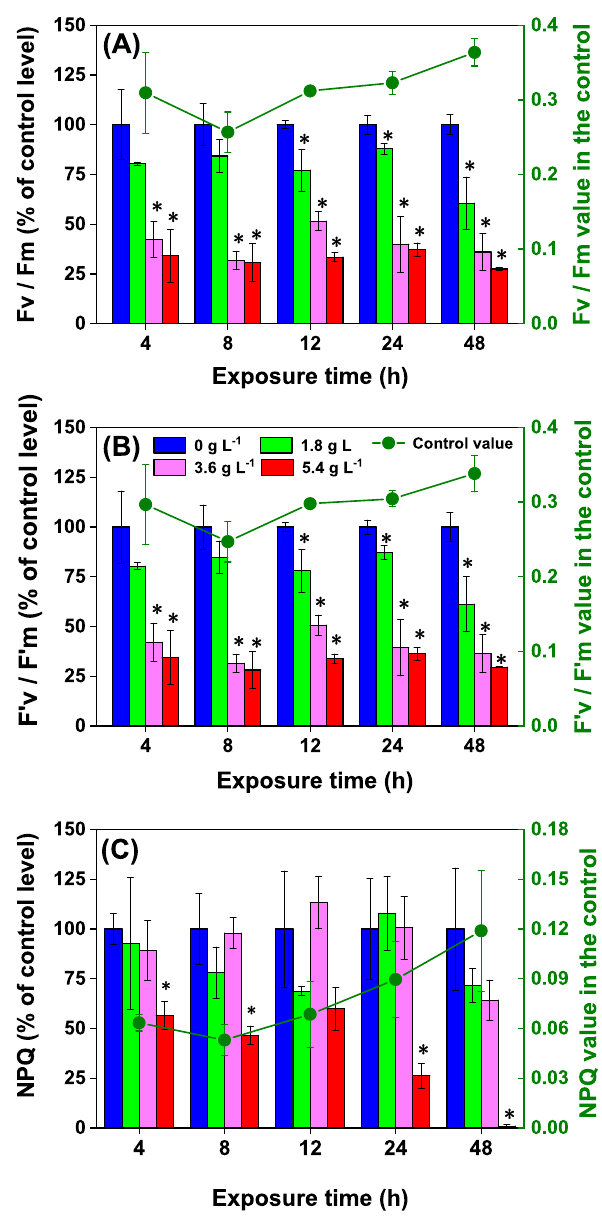
′ NPQ of Dolichospermum flos-aquae treated with aqueous extract of / F ′ Figure 7. The Fv / Fm , F m and v watermelon peel (WMPAE) at different concentrations. (Data are shown as mean ± standard deviation for n = 3, * indicates p <